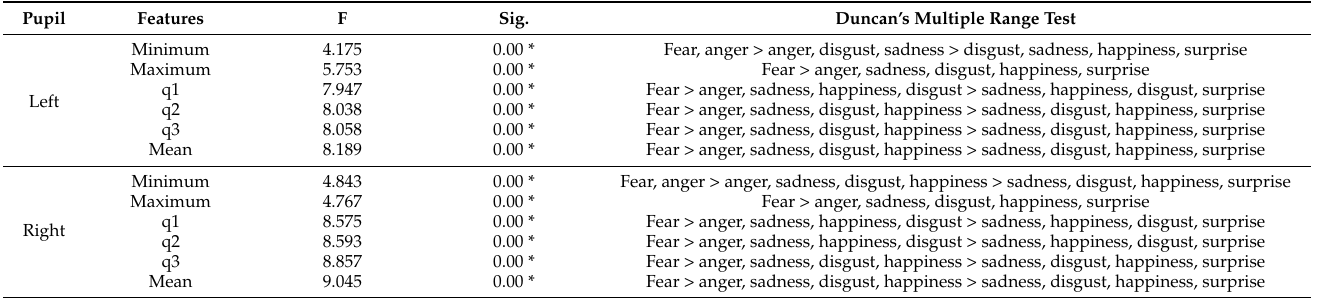
Table 3. ANOVA results and post hoc